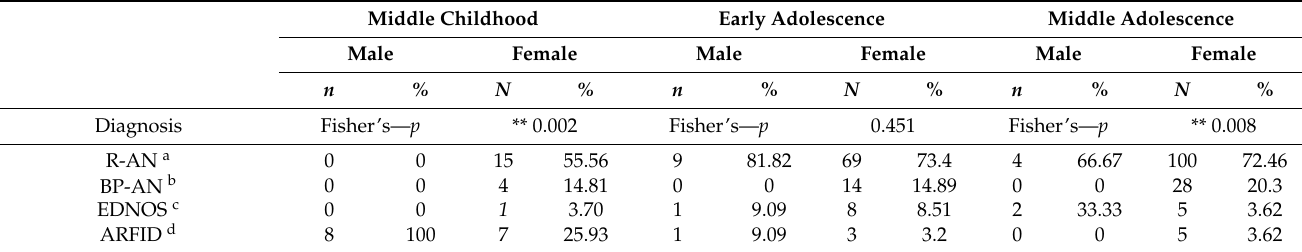
Table 4. Socio-demographic and medical characteristics of